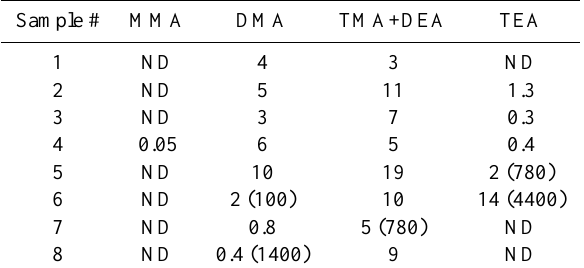
Table 2. The maximum mass loading (ng m − 3 ) on a single stage, for each amine species quantified in the MOUDI sample. The me- dian diameter (nm) of the size bin where each species maximizes is given in parentheses when it is not the 320–560nm size bin. No amines were consistently detected in all size bins from 0.056 to 18µm, so a range was not reported as the lower value would al- ways be below the limit of detection. ND indicates the species was not detected on any stage of the